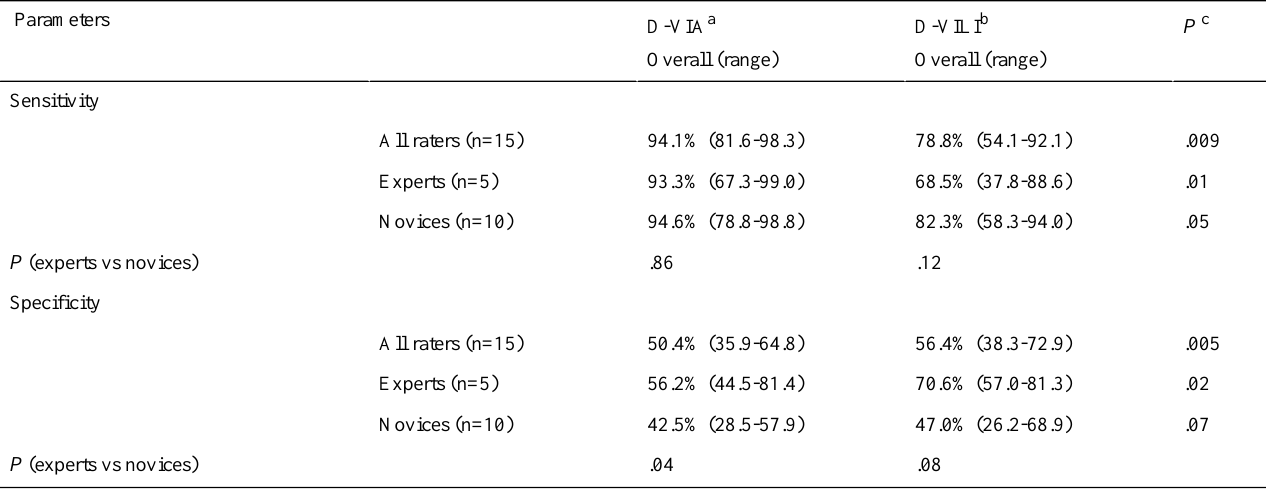
Table 2. Sensitivity, specificity, and P value for D-VIA and D-VILI among all raters, experts, and novices